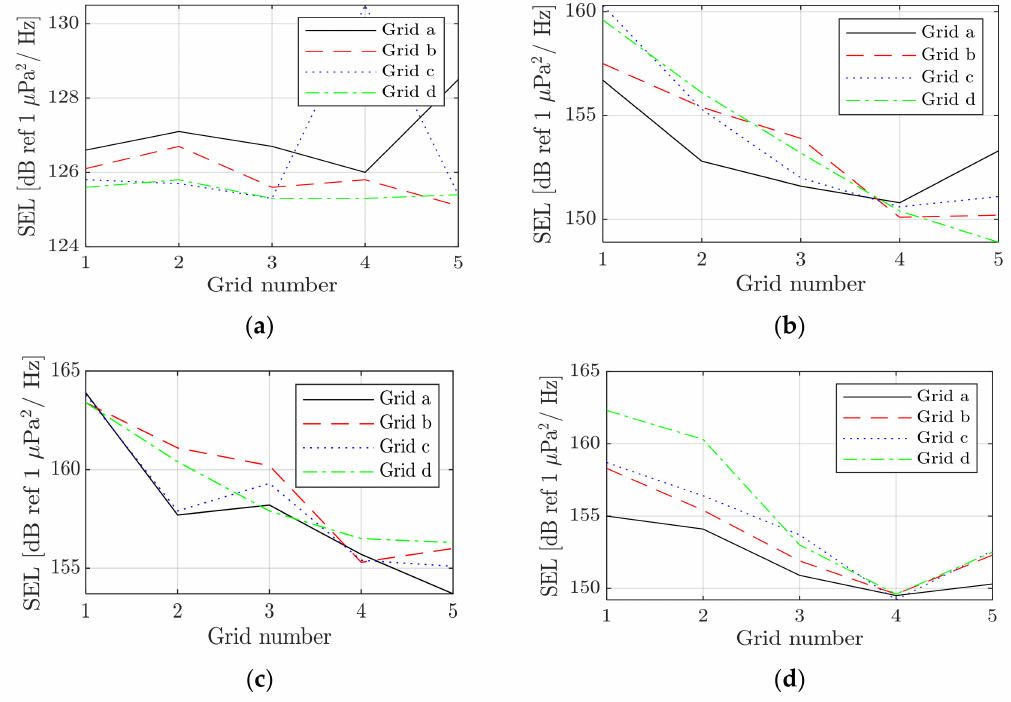
Figure 13. Sound exposure levels (SELs) calculated for ( a ) noise level, ( b ) stage 1, ( c ) stage 2, and ( d ) stage